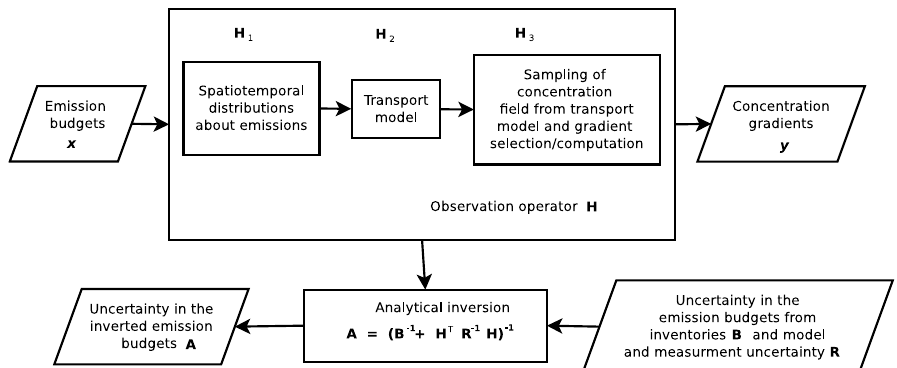
Figure 1. Diagram of the principle of the city CO 2 emissions inversion system and of the computation of uncertainties in the inverted emission budgets. Note that there is no computation of x and y vectors in this OSSE